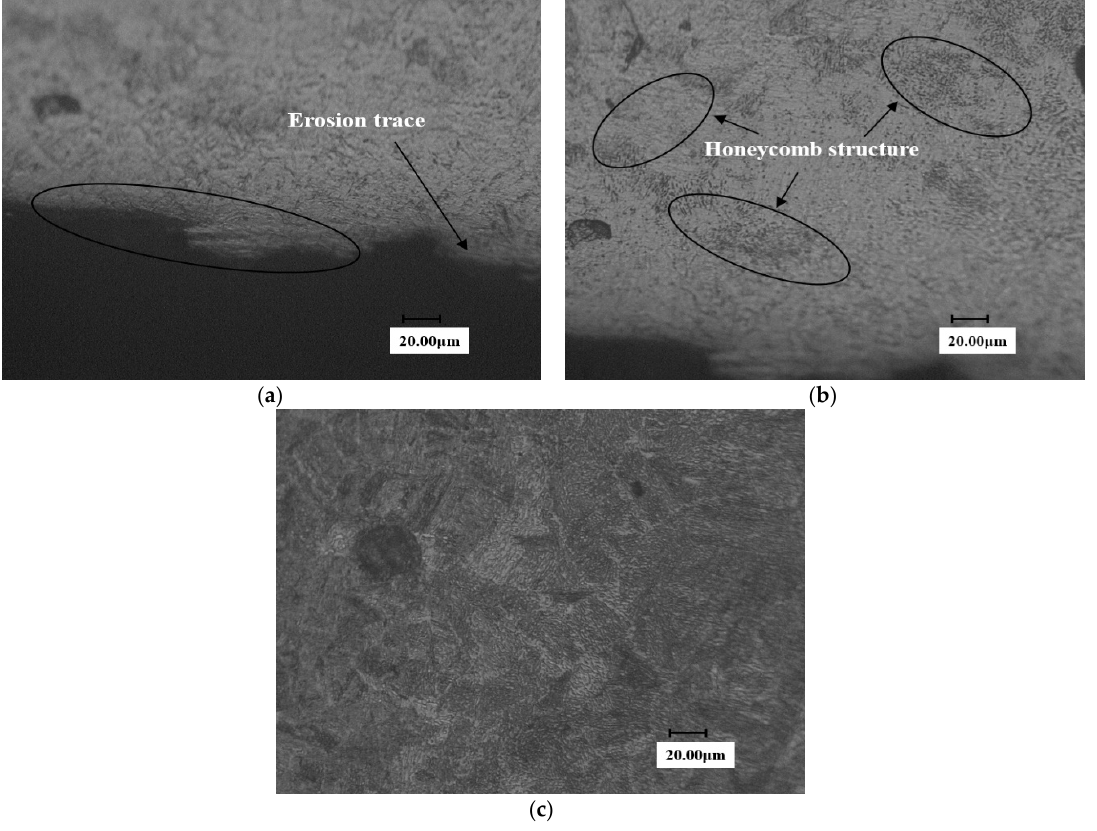
Figure 12. Surface metallographic diagram of solid solution reinforced samples. ( a ) Close to end face of the erosion trace ( b ) transition zone of laser solid solution strengthened sample ( c ) Substrate section of laser solid solution strengthened sample.